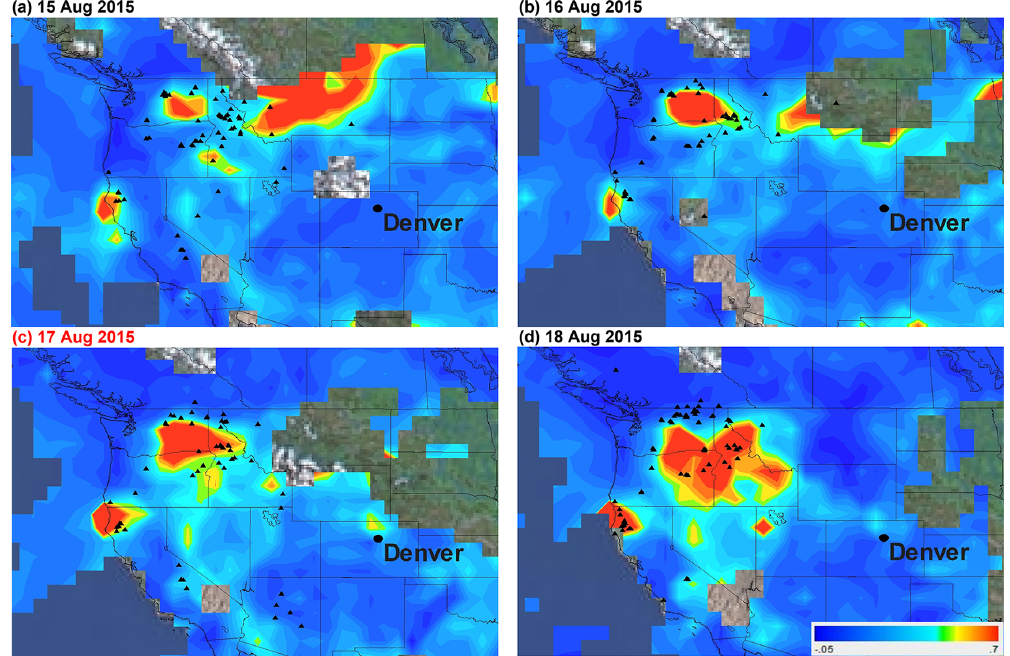
Figure 4. Daily averaged aerosol optical depth (AOD; color bar, lower right) at 550nm and fire hot spots (black markers) detected by MODIS during the first major haze case study between 15 and 18 August 2015. The haziest day from the CDPHE data is labeled in red (i.e., event 1).